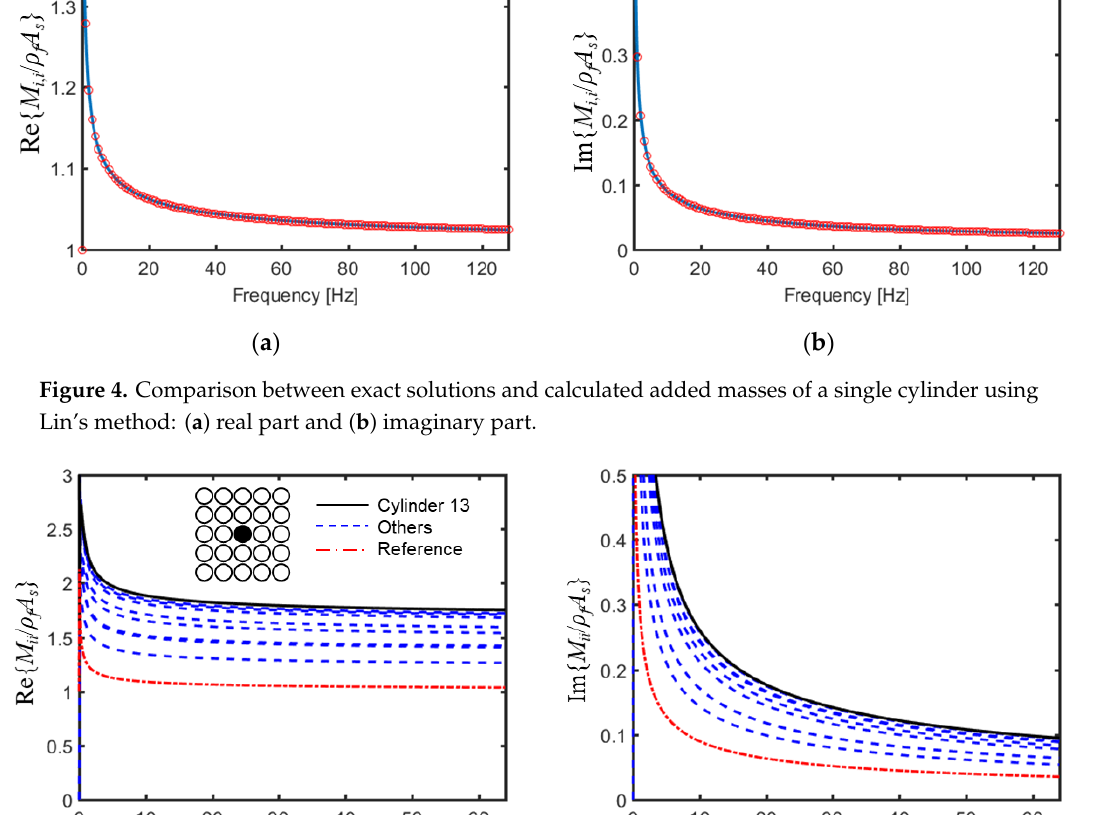
Figure 6. Pressure wave pattern produced by the multiple scattering of the plane wave with a wavelength of ( a ) k f R = 0.5, ( b ) k f R = 1.0, and ( c ) k f R = 2.0. The left, middle, and right sides of the contours represent wave propagation with one, nine, and 25 cylinders. Figure 7 shows the external forces from the unit pressure of the incident wave. The external forces were proportional to the input frequency of the incident wave. The forces acting on cylinders